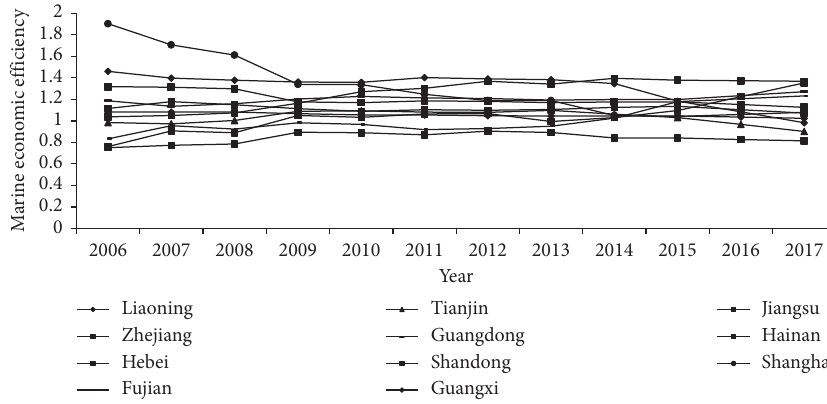
Figure 2: The changing trend of marine economic efficiency in coastal provinces between 2006 and